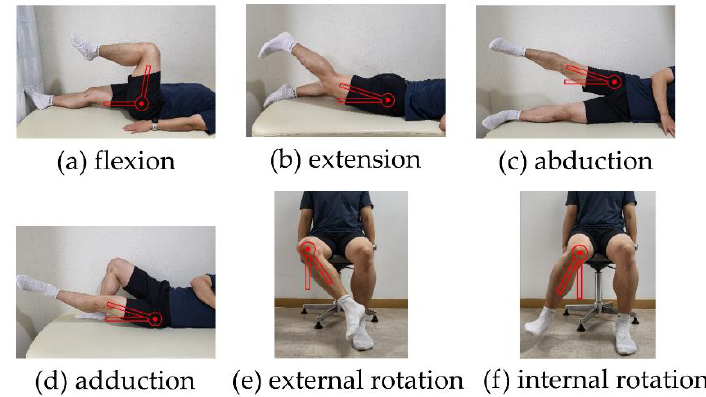
Figure 3. Hip range of motion measurement with goniometer.